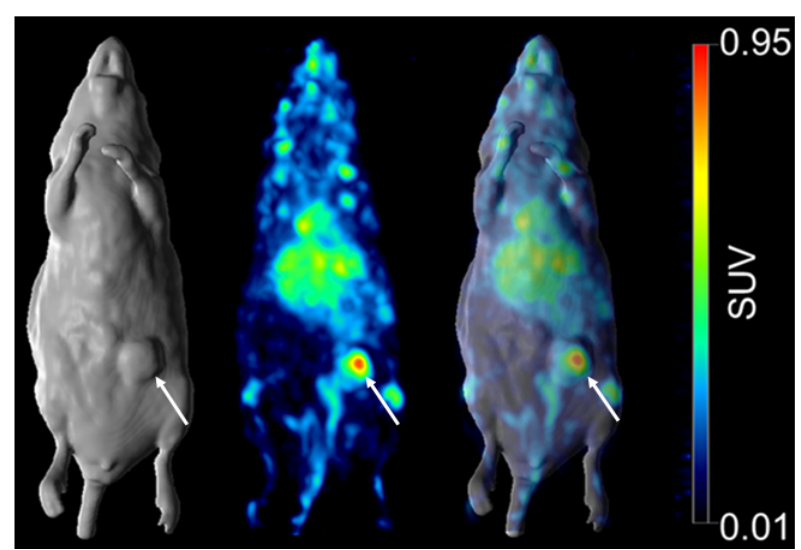
Figure 6. PET / MR imaging of 89 Zr-ch806 on day 7 post-injection in a MSTO-211H xenograft-bearing BALB / c nude mouse (from left to right: whole-body MR (surface rendered), PET (maximal intensity projection) and fused PET / MR). Tumor-specific uptake (arrow), and some liver, spleen and bone uptakes, are